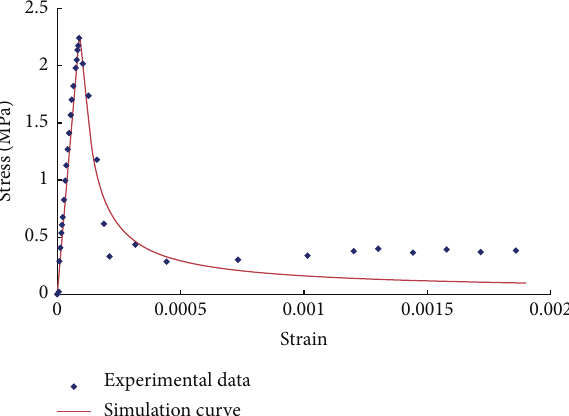
Figure 6: Comparison of stress-strain relationship between numer- ical simulation and experimental tests for specimen A2.